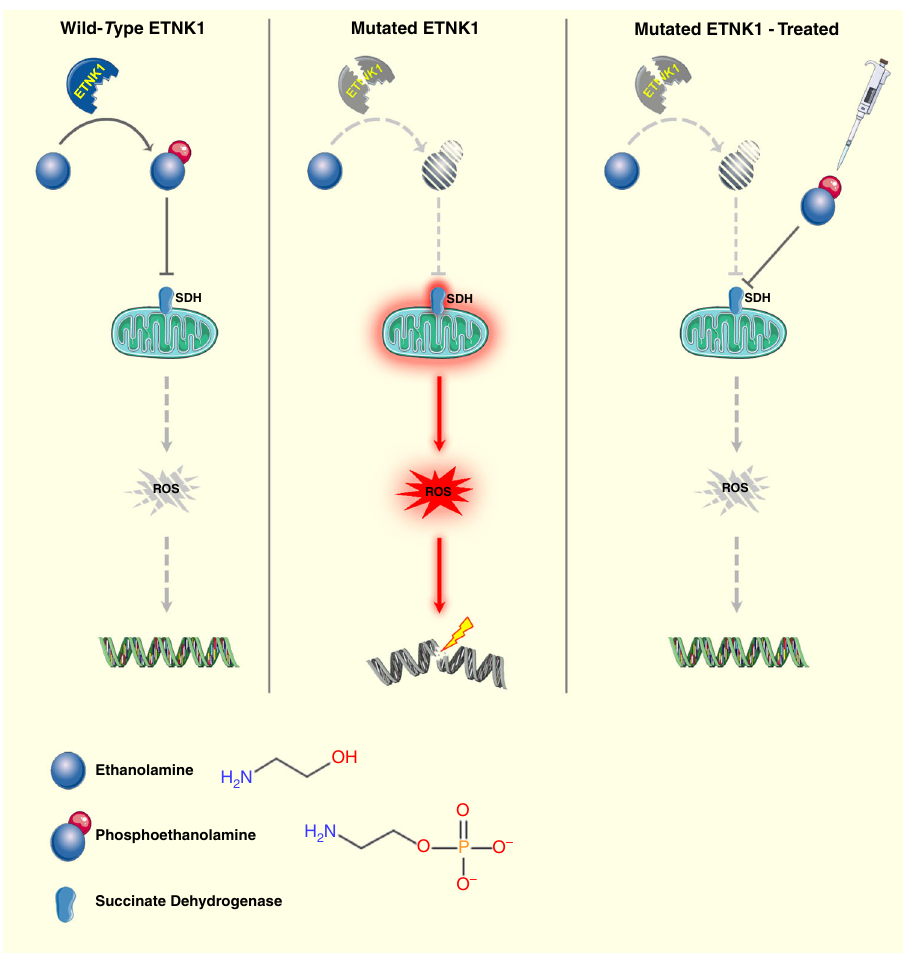
Fig. 7 Diagram showing the proposed model for ETNK1 mutations. Left panel: wild-type ETNK1 actively phosphorylates Et leading to the accumulation of P-Et, which in turn negatively modulates mitochondrial activity and ROS production through inhibition of SDH. Middle panel: in the presence of mutated ETNK1 the production of P-Et is impaired, which causes abnormal mitochondrial activation, increased ROS production and DNA damage. Right panel: treatment of ETNK1-mutated cells with exogenous P-Et leads to restoration of normal mitochondrial activity through suppression of SDH, normalization of ROS production and protection of DNA from ROS-mediated damage. Elements of the image were obtained from https://smart.servier.com/ under a Creative Commons Attribution 3.0